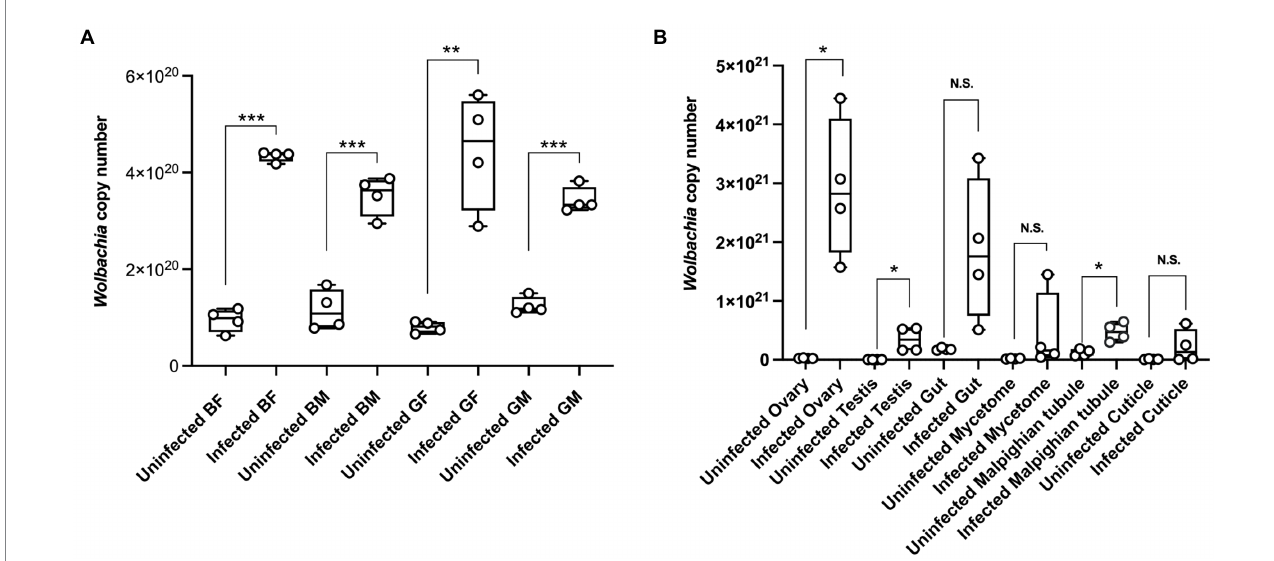
FIGURE 4 The Wolbachia dynamic titer in different color morphs and tissues of the C Las uninfected and infected ACP. (A) Different color morphs and genders of ACP adults. (B) Different tissues of ACP. Comparison of the difference of qPCR data was analyzed by Student’s t -test (*, p < 0.05; **, p < 0.01; ***, p < 0.001, p > 0.05 means no significant difference. N.S., no significance). BF, blue-female; BM, blue-male; GM, gray-male; GF,